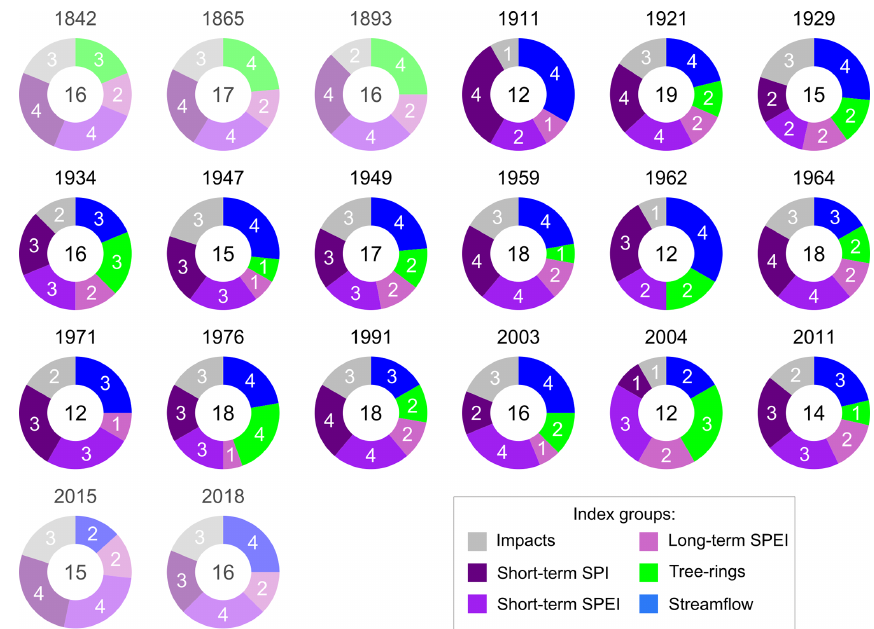
Figure 5. Drought years in which more than 10 indices (from different categories) indicate a drought (the total number of indices pointing to a drought is written in the circle, and the number of indices per group pointing to a drought is written in each section of the ring). Years without streamflow data (prior to 1900) or without tree-ring data (after 2011) are displayed with paler